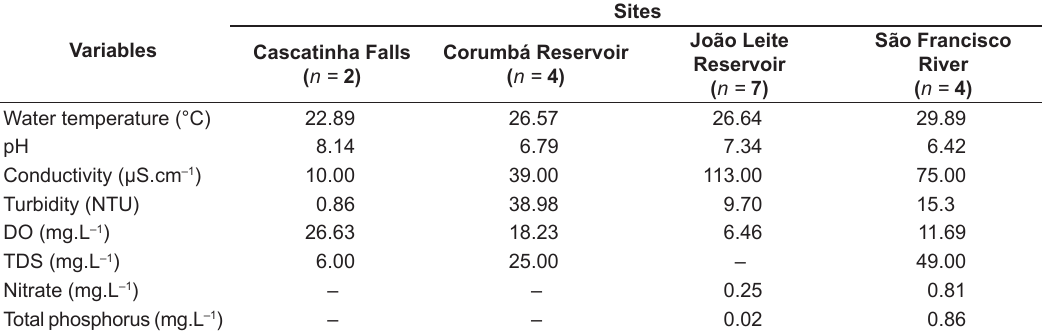
Table 3. Mean values of physical and chemical variables analyzed in reservoirs and rivers in the Corumbá River basin, Goiás, and the São Francisco River basin, Alagoas (ORP: oxidation-reduction potential; DO: dissolved oxygen; TDS: total dissolved